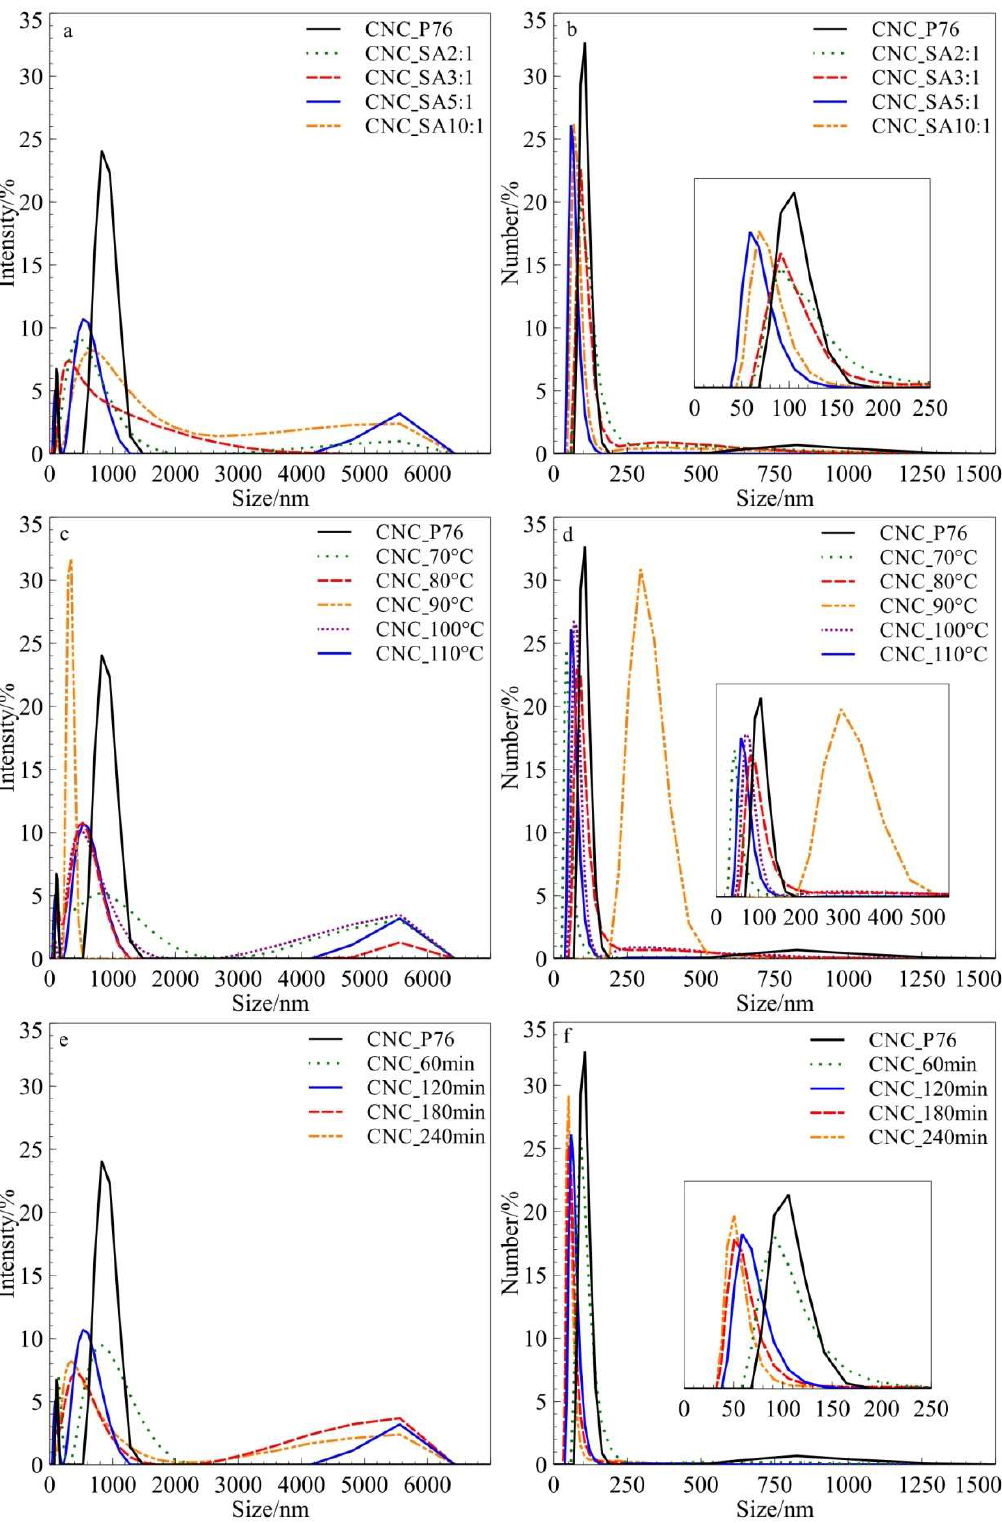
Figure 2. Particle size distribution for CNC_SA obtained at ( a , b ) different SA:OH molar ratios; ( c , d ) temperatures; and ( e , f ) time of reaction by intensity and number, respectively.